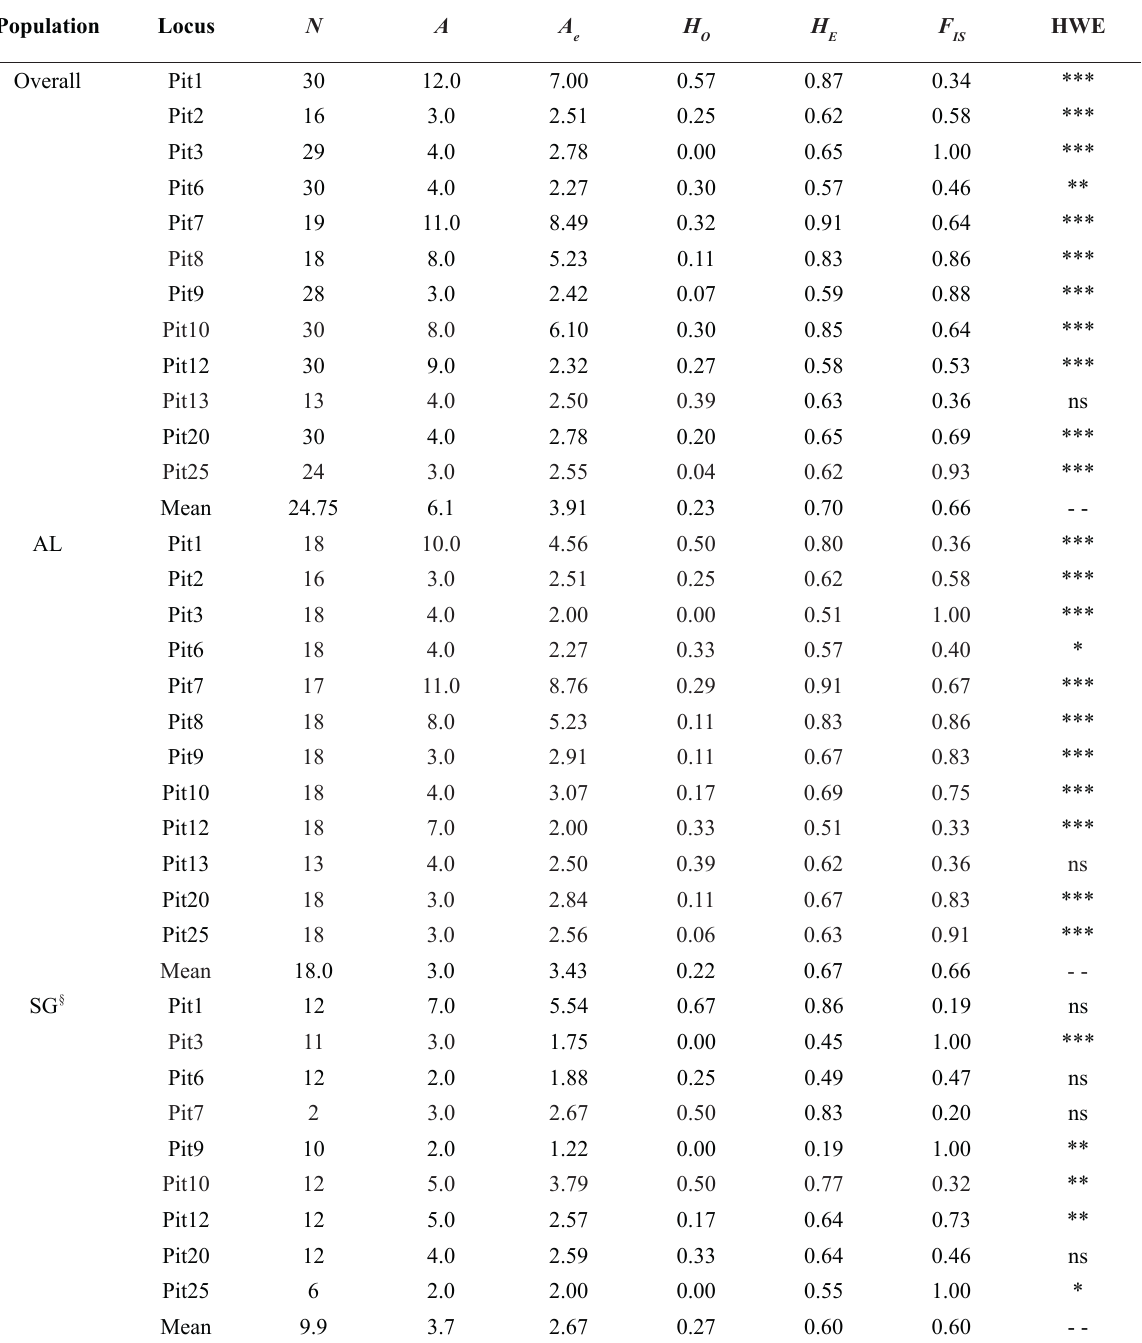
Genetic parameters estimated for Eugenia uniflora based on 12 SSR markers characterized in this study, overall populations and at population level. Estimations include the number of samples ( N ), number of allele per locus ( A ), effective allele number ( A ), observed ( H ) and expected ( H ) heterozigosities, Wright’s within population fixation index e O E ), and statistical significance of the deviation from Hardy-Weinberg equilibrium ( F IS